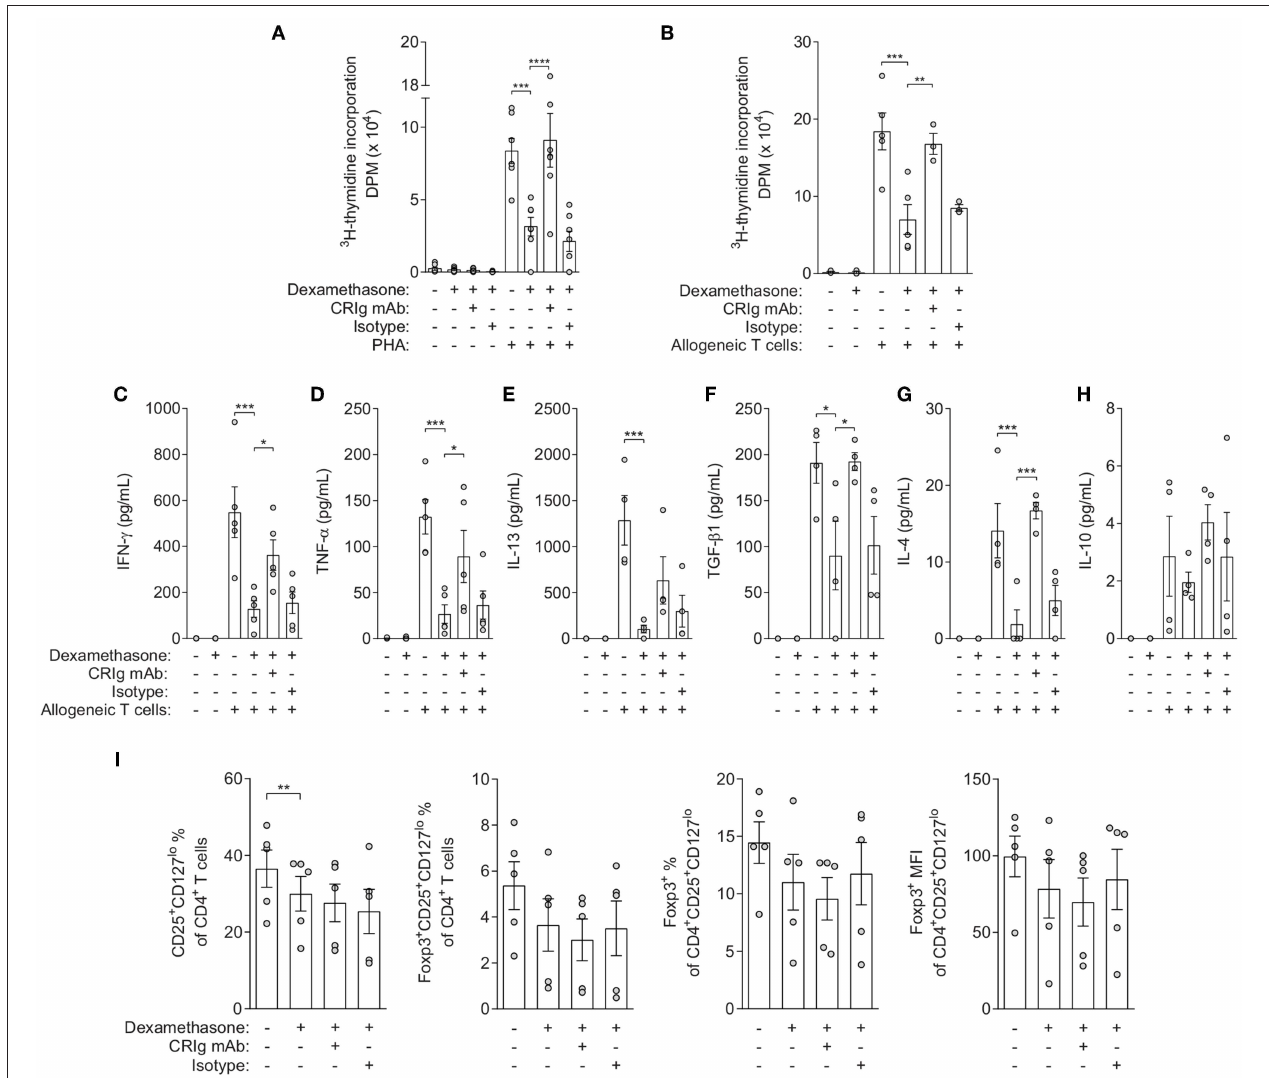
FIGURE 2 | Effects of dexamethasone conditioned DCs and anti-CRIg monoclonal antibody on PHA- and allogeneic-induced T cell proliferation, cytokine production and generation of iTreg. (A) 3 H-TdR incorporation (DPM) in autologous DC-T cell co-culture in the presence/absence of dexamethasone, anti-CRIg 6H8 or isotype control antibodies, and PHA. Data are presented as means ± SEM of 6 experiments conducted with cells from different individuals. (B) 3 H-TdR incorporation (DPM) in allogeneic DC-T cell co-culture in the presence/absence of dexamethasone treated DCs, anti-CRIg 6H8 antibody or isotype control antibodies. Data are presented as mean ± SEM of 5 experiments. (C–H) Effects on cytokine production in allogeneic DC-T cell cultures. Data are presented as mean ± SEM of 4–5 experiments. (I) Effects on generation of iTreg in allogeneic DC-T cell cultures. Data are presented as mean ± SEM of 4 experiments. Note that normalized data for the above cytokine production and Treg generation is presented in Supplementary Figure 3 . Significance levels are indicated by asterisks: * P < 0.05, ** P < 0.01, *** P < 0.001, **** P <